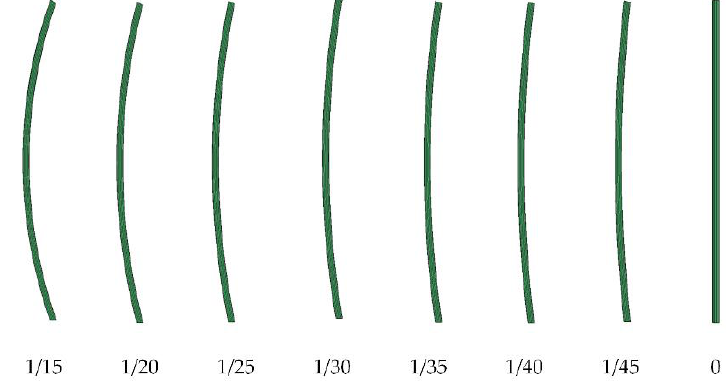
( b ) Figure 27. Diagram of TNT position. ( a ) vertical view; and ( b ) left view. Figure 28a,b shows the δ max – k curve and the TEA – k curve of the global blast wall, respectively. It can be seen that with the increase of curvature k , both the energy absorbed by the blast wall and the maximum deflection gradually increases. In addition, the com- prehensive blast resistance index P was calculated according to δ max and TEA , and the re- sult of P shows that when the curvature is 1/20, the value of P is the maximum, which demonstrates that when the curvature is 1/20, the anti-blast performance is the best. ( a ) δ max – k curve ( b ) TEA – k curve Figure 28. The curve of anti-blast index and different curvature. Furthermore, the deformation contour of the blast wall of OBW-1 and OBW-2 with curvature of 1/20 is shown in Figure 29a,b. It can be seen that the maximum deflection δ max 0 . 000 . 010 . 020 . 030 . 040 . 050 . 060 . 07 0 . 34 0 . 36 0 . 38 0 . 40 0 . 42 0 . 44 0 . 46 0 . 48 δ m a x ( m ) C u r v a t u r e